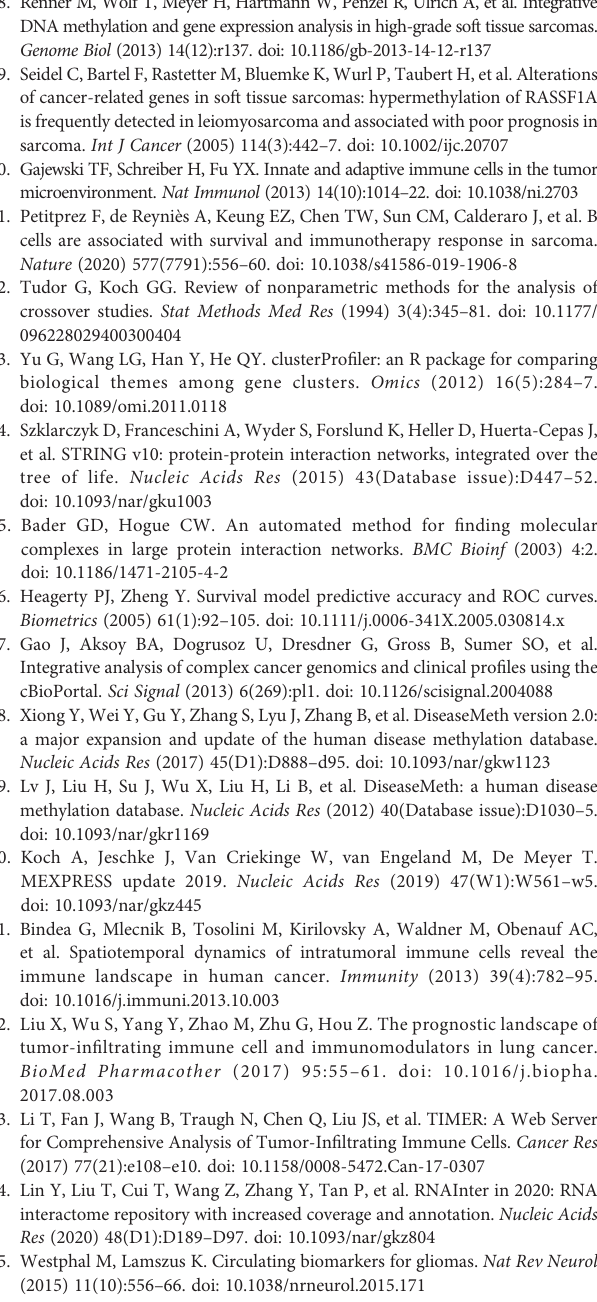
Supplementary Figure 1 | Association of methylation sites with expression of STS hub RBPs. Note: (A) BYSL, (B) CD3EAP, and (C) MEX3A. Supplementary Figure 2 | Potential interactions of 9 hub RBPs. Note: (A) TLR7, (B) TERT, (C) SRSF12, (D) MEX3A, (E) IGF2BP3, (F) DNMY3B, (G) CD3EAP, (H) BYSL and (I) TRIM21. Supplementary File 1 | Detailed information of patients with STS. Supplementary File 2 | The expression matrix of 1492 RBPs from STS and normal tissue samples.